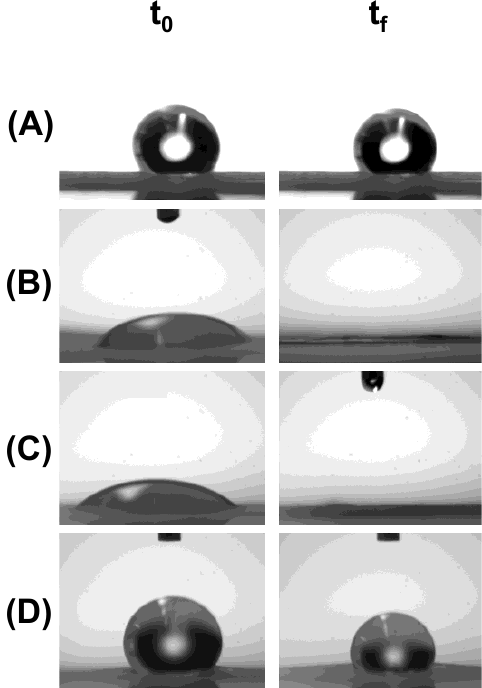
Figure 3. Wettability of PCL 394 fibers prepared in the absence ( A ), and in the presence of 2.5 wt% of PEO 45 -b- PCL 11 ( B ), PEO 148 -b- PCL 13 ( C ), and PEO 230 -b- PCL 184 ( D ), respectively.